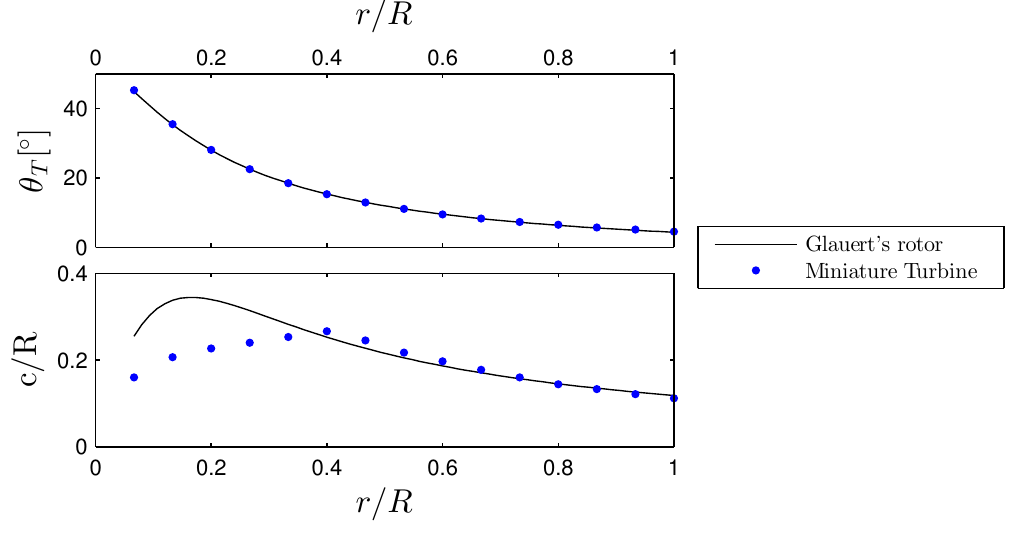
Figure 3. Twist and chord distributions for the blade of the miniature turbine shown by blue circles. The ones suggested by the Glauert design method are shown with black lines.